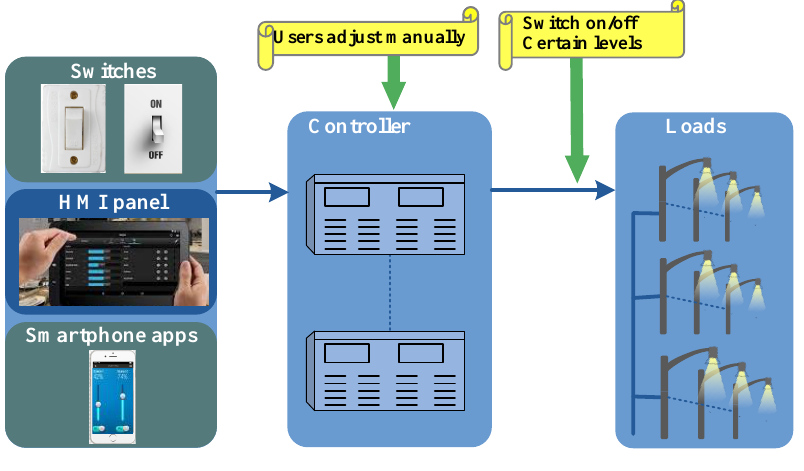
Figure 1. Manual control scheme.